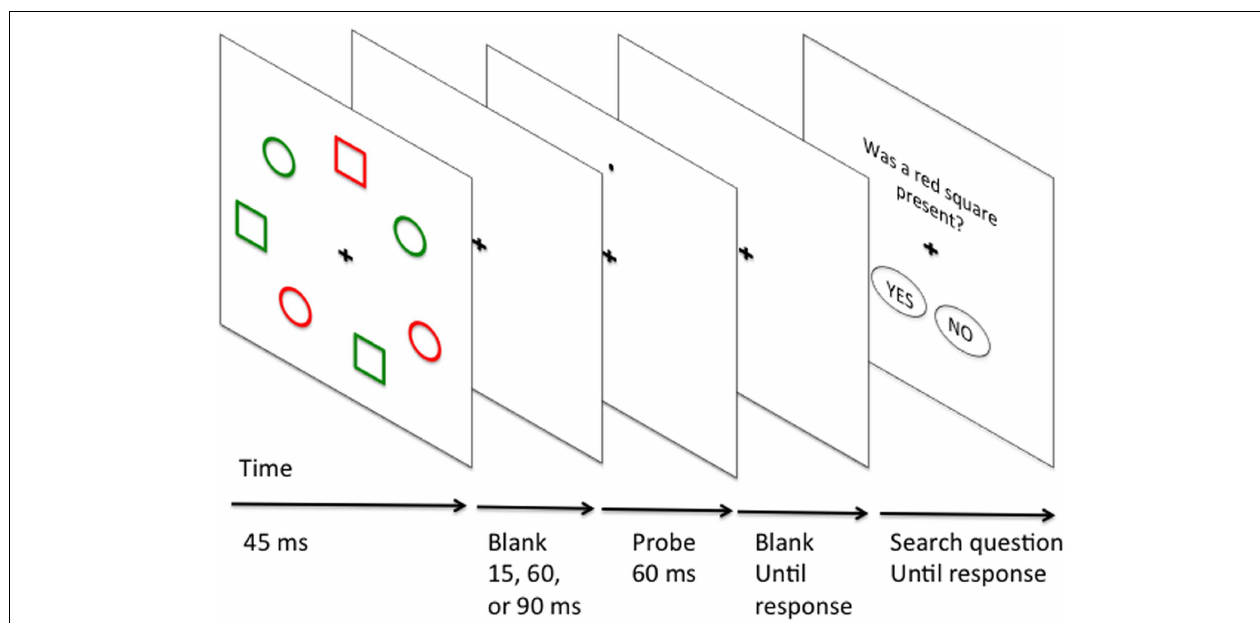
FIGURE 3 | Illustration of Kim and Cave (1995) probe-dot study of conjunction search. Target is a red square. Distractors share either shape (green square), color (red circle) or neither feature (green circle) with the target.